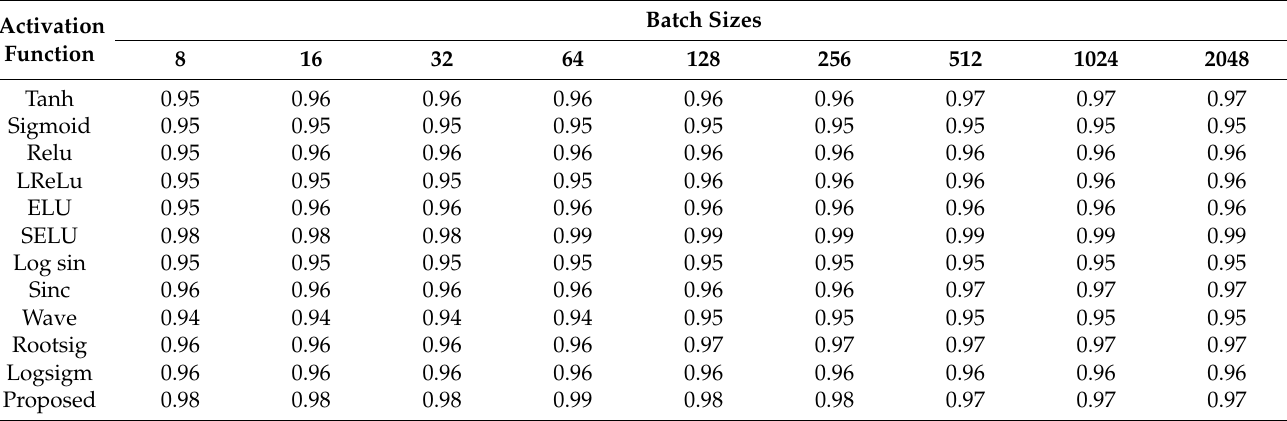
Table 4. Comparison of accuracy proposed with state-of-the-art activation functions on different batch sizes.